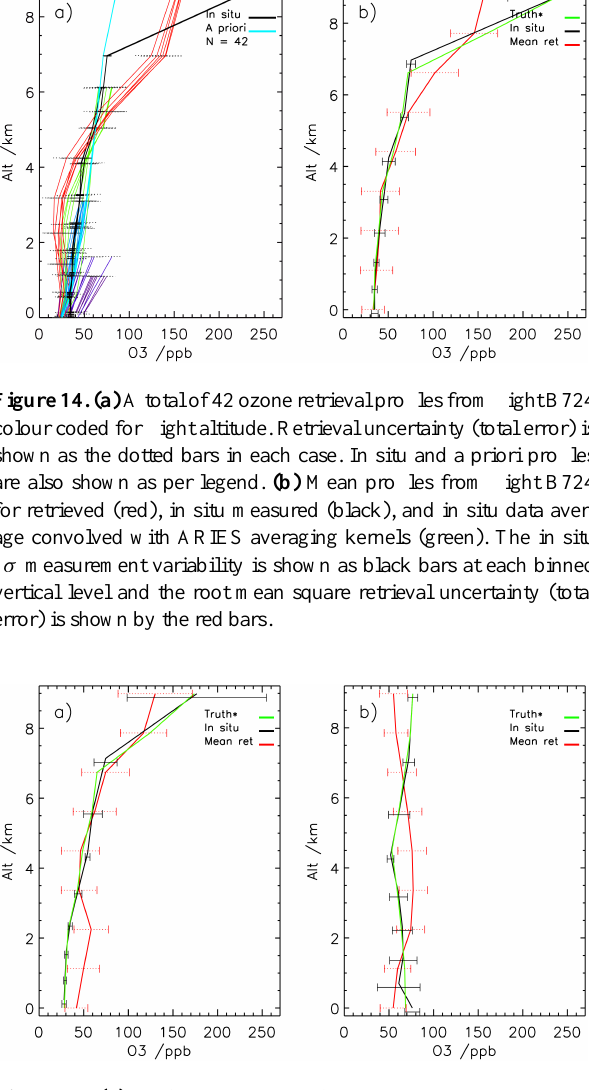
Figure 15. (a) As for Fig. 14b but for 58 ozone concentration re- trieval profiles averaged for flight B720; (b) as in Fig. 14b but for 191 ozone concentration retrieval profiles averaged for flight